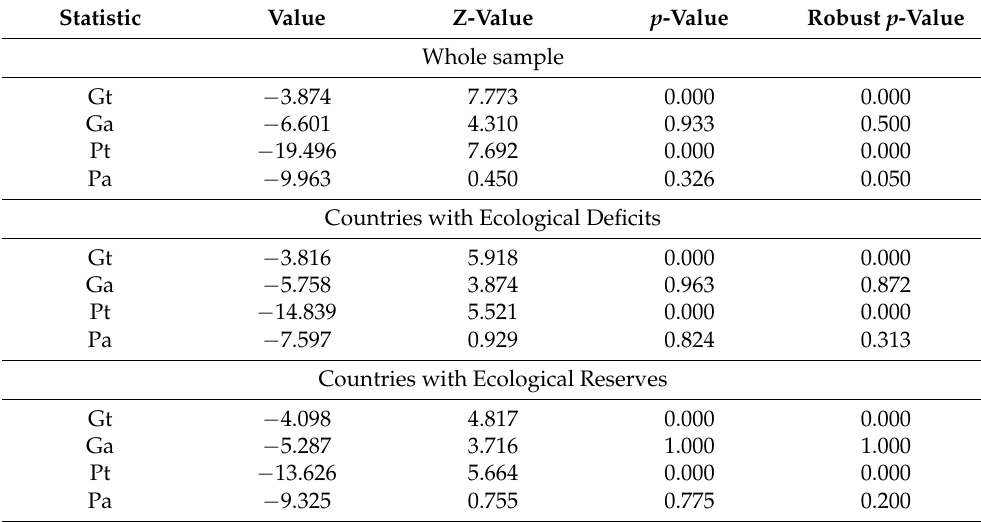
Table 6. Results of Westerlund cointegration test.